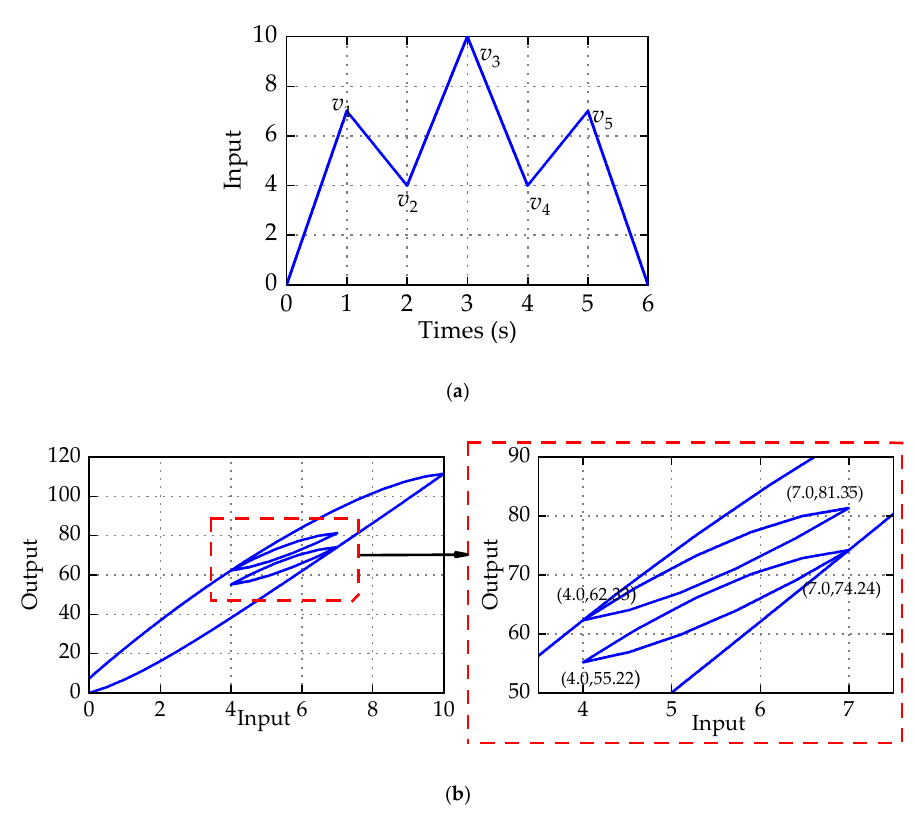
Figure 8. Simulation of the congruency property. ( a ) Input voltage. ( b ) Hysteresis loops.